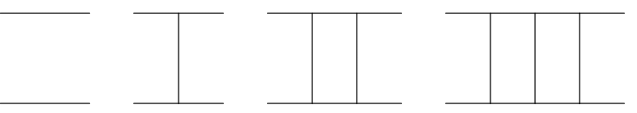
Figure 4 . The first four contributions to the ladder expansion of F s in the Amit-Roginsky model, where again we omit the crossed diagrams with x